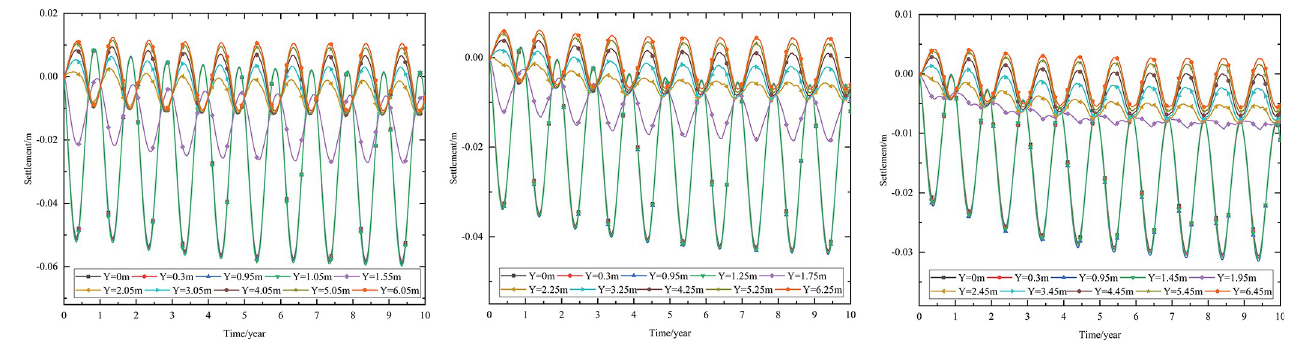
Fig 13. Settlement-time curves of pavement center with subbase layer thickness of (a) 0.10 m, (b) 0.30 m, and (c) 0.50 m.